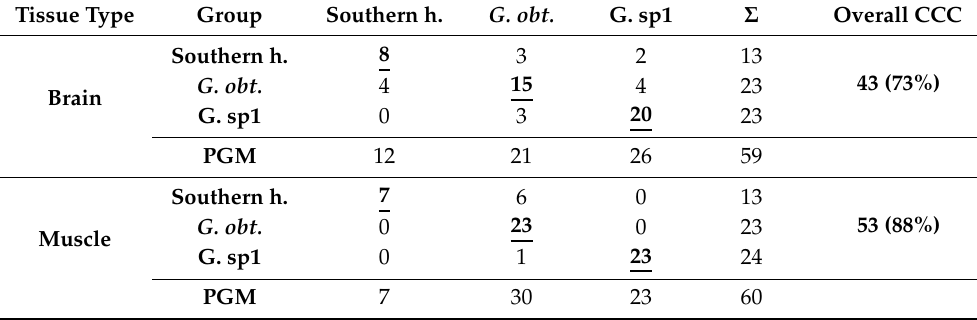
Table 5. Classification results of the genetically identified individuals sorted into the three cryptic species (haplogroups) by MSPP. In the confusion matrices the actual and predicted groups are presented in rows, and in columns, respectively. The correctly classified cases (CCC) are indicated by bold letter type in the diagonals of the tables and underlined. The overall CCC is the ratio of correctly classified (cid:80) individuals to the total number of individuals. : number of individuals originally classified into a certain group. PGM: predicted group membership.